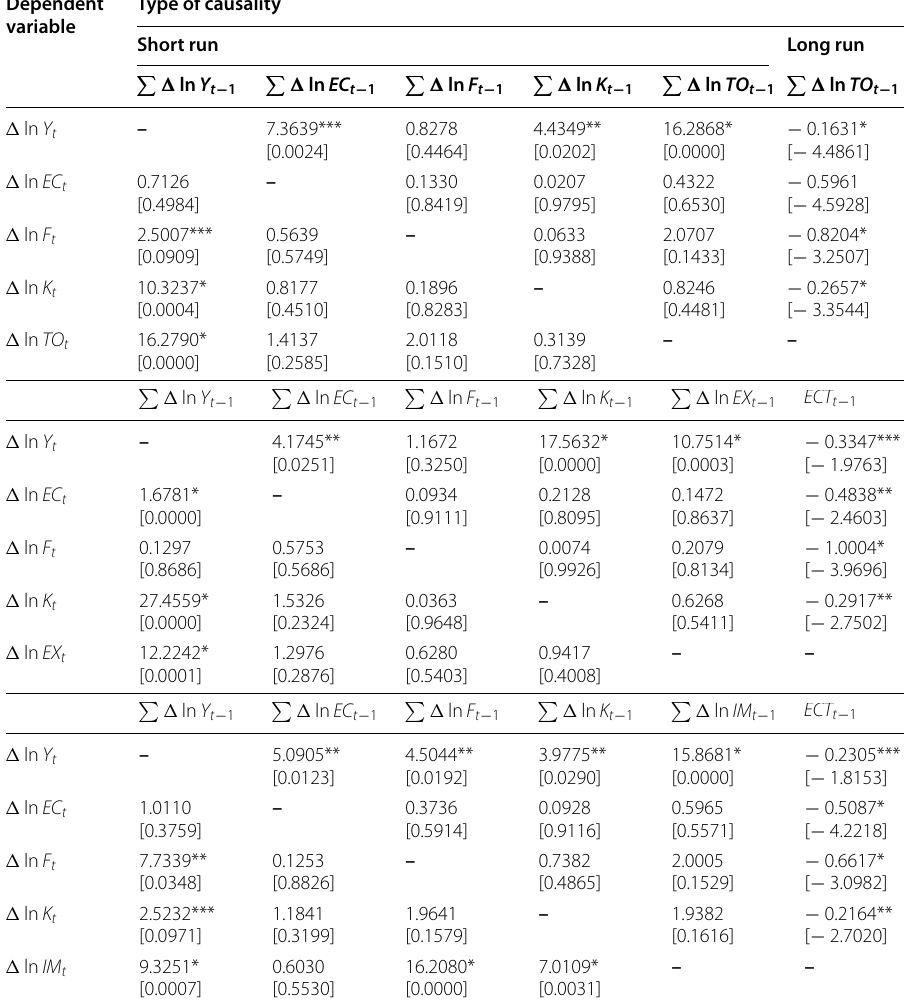
* , ** and *** indicate the level of significance at 1%, 5%, and 10%, respectively